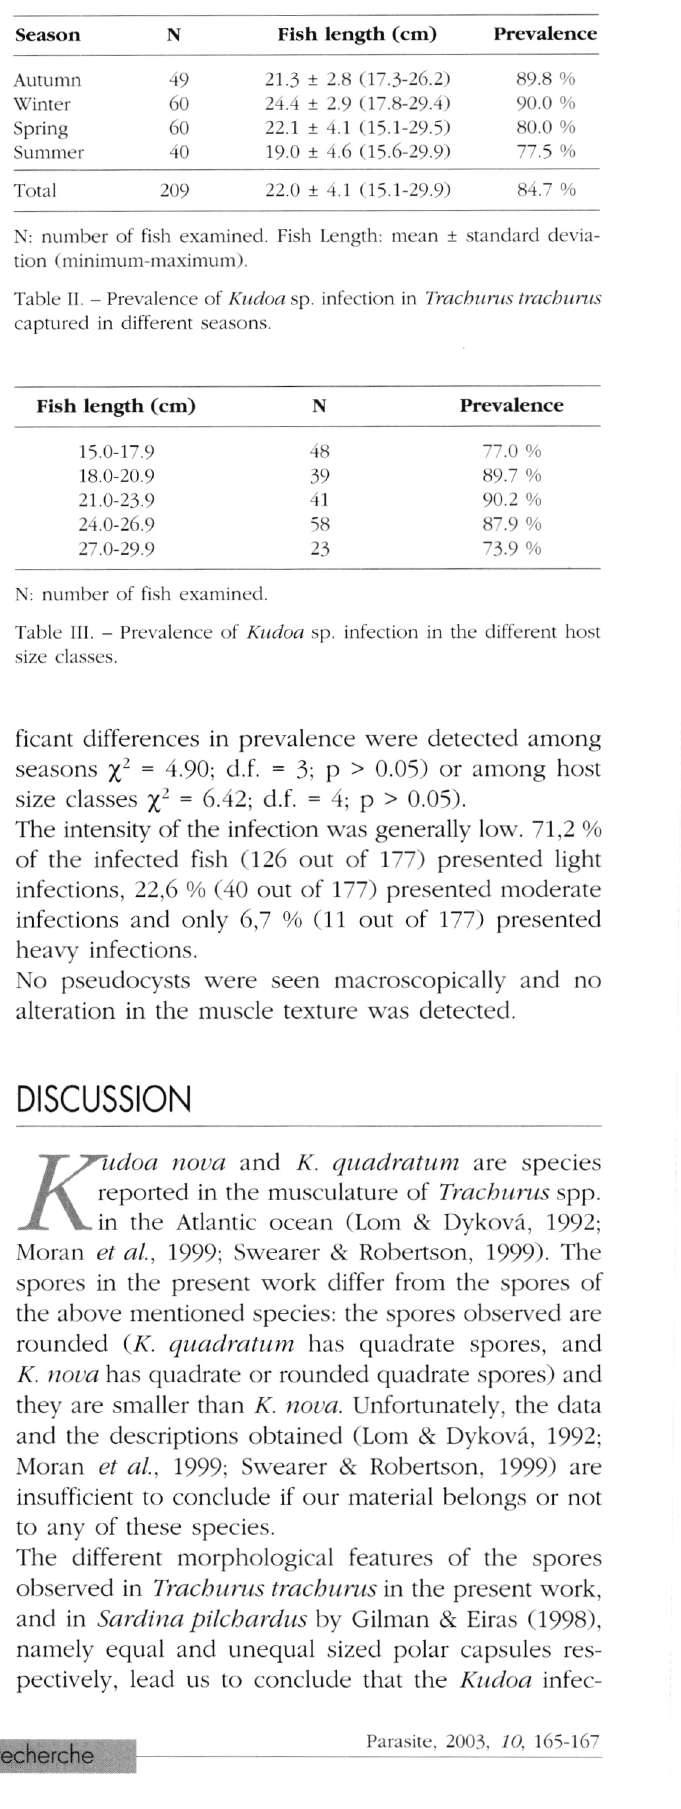
Fig. 1. - Kudoa sp. spores (a: lateral view; b: apical view) in muscle.